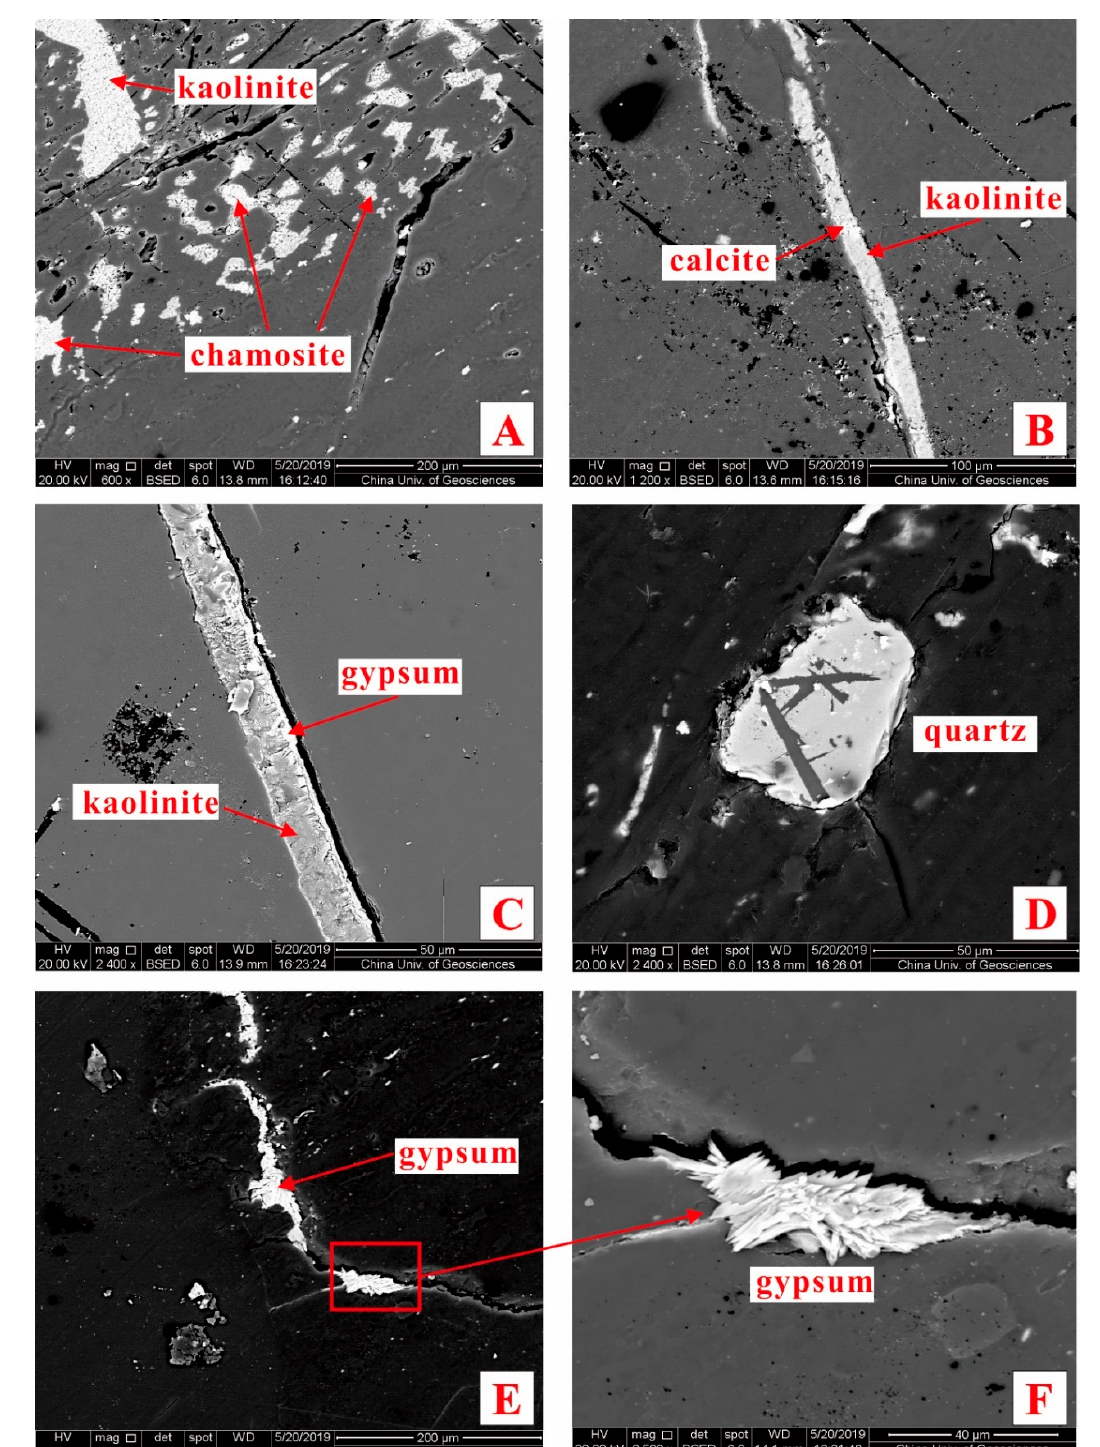
Figure 5. SEM back-scattered images of kaolinite, chamosite, calcite, gypsum and quartz (sample CJG 3-4). ( A ) syngenetic cell-filling chamosite and cleat/fracture-filling kaolinite; ( B , C , E , F ) cleat/fracture-filling kaolinite, gypsum and calcite; ( D ) Sub-round quartz grain associated with organic matter.